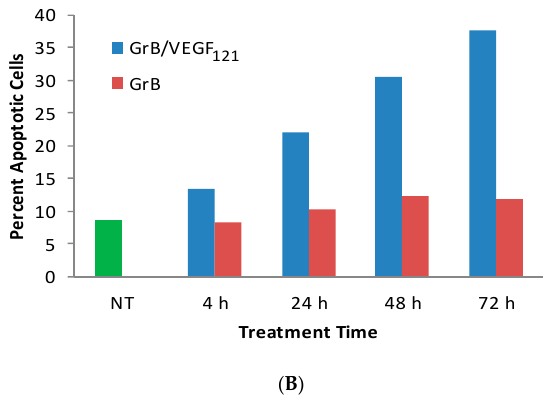
Figure 4. GrB/VEGF 121 triggers apoptosis in target cells. ( A ) Annexin V/PI staining at 24 h after onset of incubation with GrB/VEGF 121 . Circles indicate the percent of cells in early apoptosis. ( B ) Induction of apoptosis over 72 h in VEGFR-2-overexpressing endothelial cells by the targeted GrB/VEGF 121 compared to the non-targeted GrB. Green: untreated control; red: GrB treatment; blue: GrB/VEGF 121 treatment.